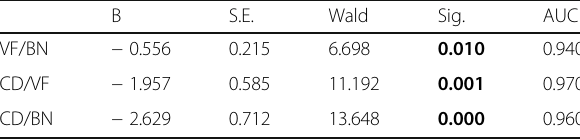
Table 3 Binary logistic regression analysis for different probabilities of combined tests B S.E.